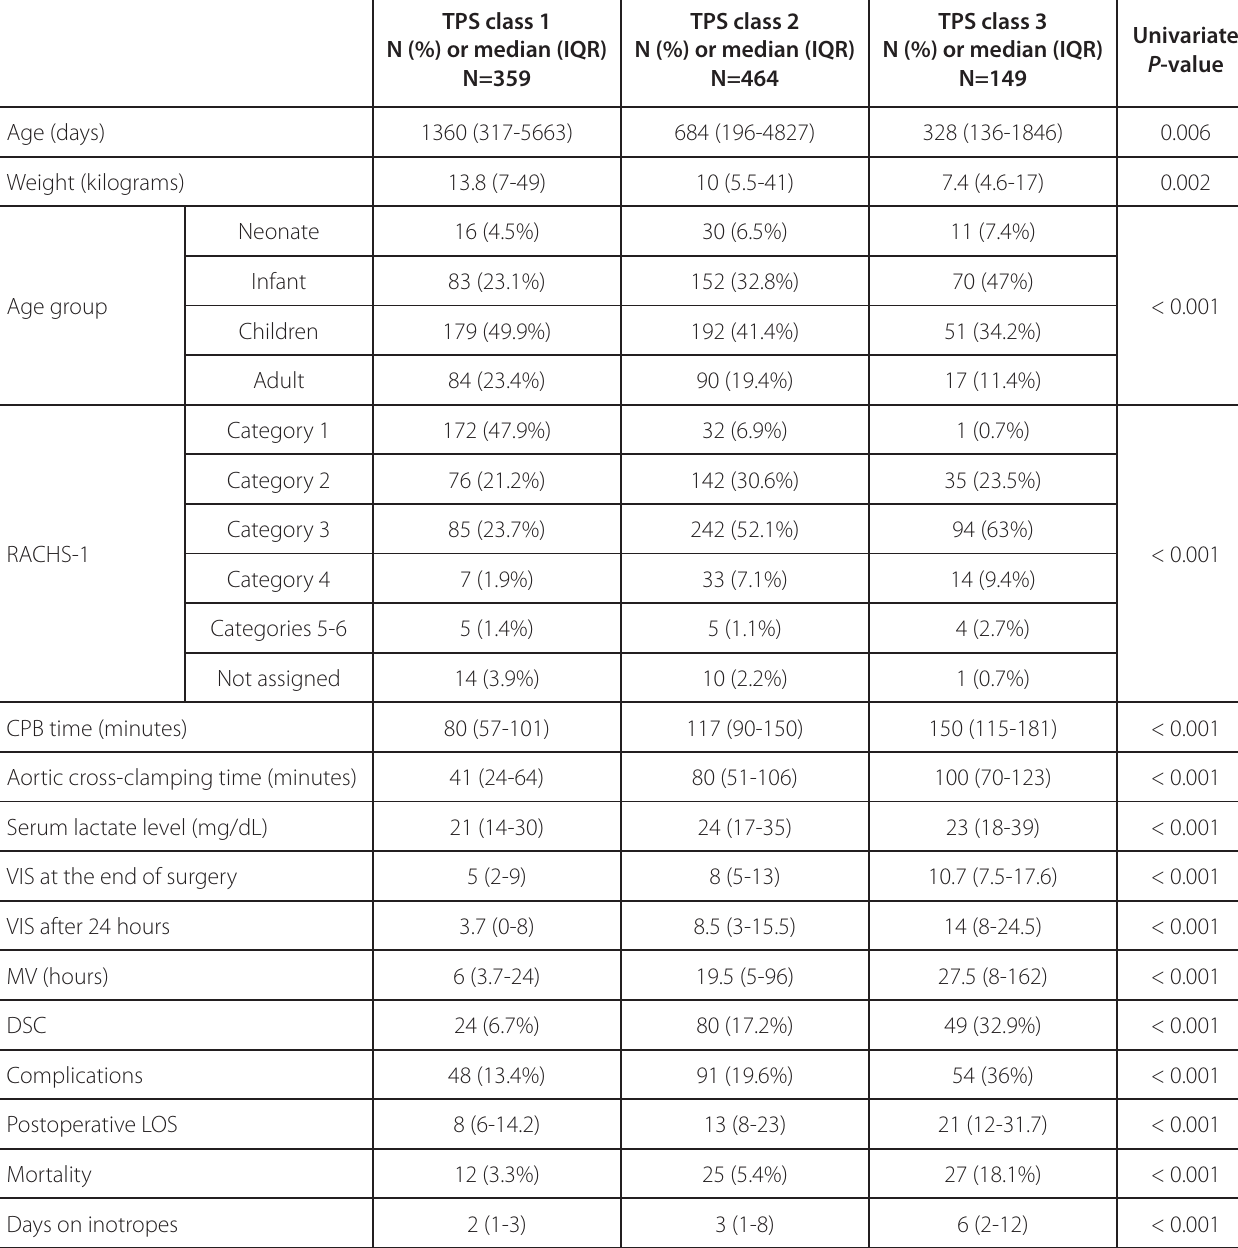
Table 3 . Variables stratified by Technical Performance Score (TPS)